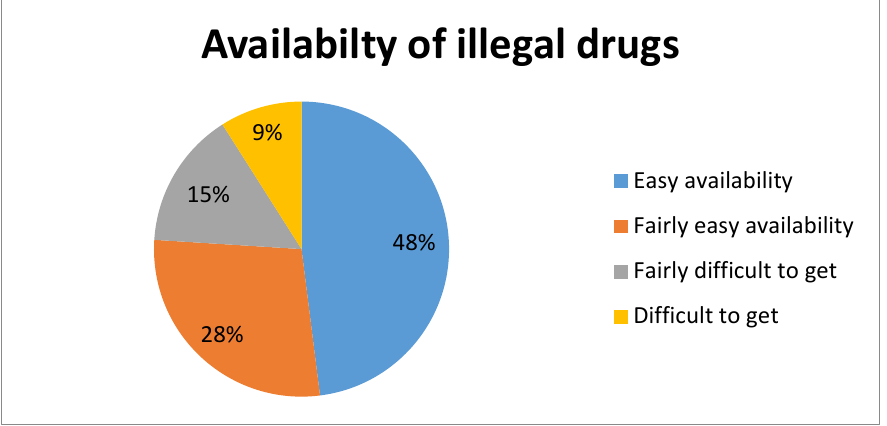
Figure 3. Accessibility of illegal drug Sources of Information on Drug Abuse